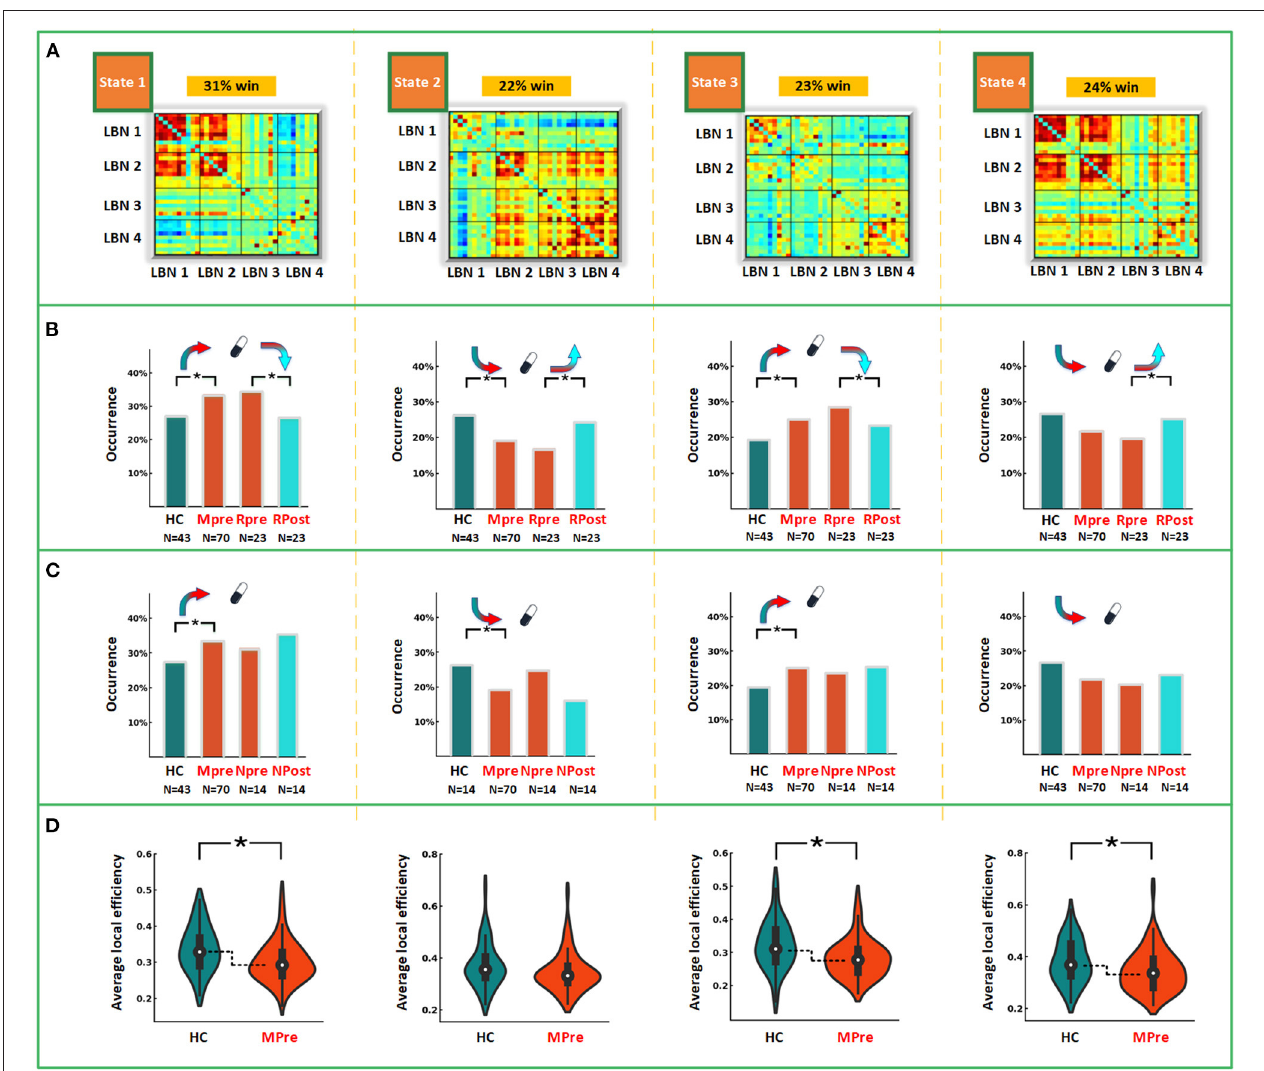
FIGURE 2 | Intra- and between-group comparisons in dynamic measures. (A) Functional interaction patterns are represented by four states. The mean occurrence proportion of each state across all subjects was listed above each matrix. (B) The differences of occurrence proportion between MDD and HC, and between post-treatment and paired baseline responsive depression group. (C) The differences of occurrence proportion between MDD and HC, and between post-treatment and paired baseline non-responsive depression group. (D) The differences of average local efficiency between MDD and HC. LBN, large-scale brain network; win, window; HC, healthy controls; Mpre, major depressive disorder patients at baseline; Rpre, responsive depression group at baseline; Rpost, responsive depression group after treatment. Npre, non-responsive depression group at baseline; Npost, non-responsive depression group after treatment. * p < 0.05 after FDR